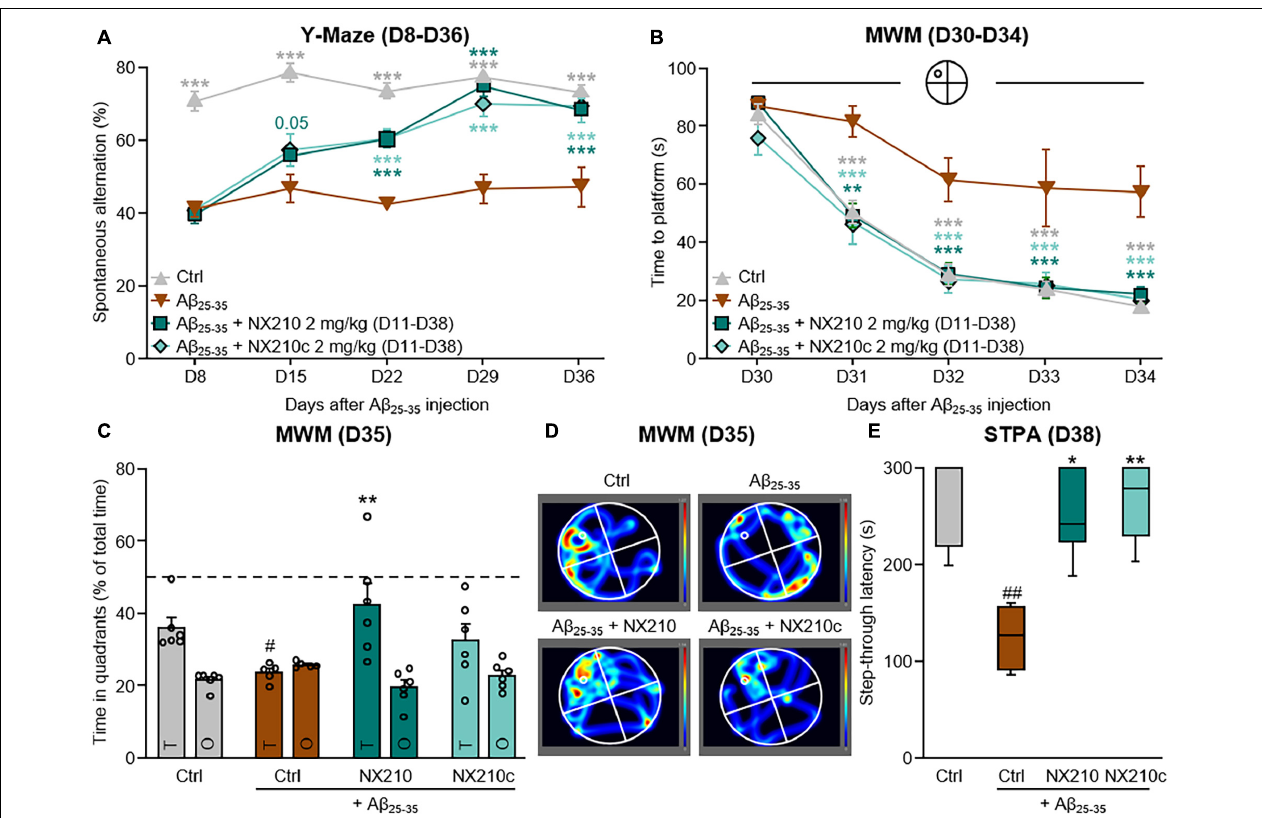
FIGURE 4 | Late-stage daily treatment with NX210 or NX210c restores amyloid-beta 25 - 35 (A β 25 - 35 )-induced short-term cognitive impairments in mice. Mice were injected intracerebroventricularly with scrambled control peptides (Ctrl) or A β 25 - 35 oligomers, and treated intraperitoneally once a day with vehicle, NX210 or NX210c (2 mg/kg) from day 11 (D11) until the end of the experiment (D38). They were subjected to several behavioral tests to evaluate learning and memory. (A) Spontaneous alternation in the Y-maze was assessed weekly from D8 to D36 to study spatial working memory. Late-stage daily treatment with NX210 and NX210c restored working memory deficit, as shown by the increased number of spontaneous alternations in the Y-maze compared with A β 25 - 35 -injected mice treated with vehicle. The data are presented as means and SEM. Two-way ANOVA followed by Tukey’s multiple comparisons test: *** p < 0.001 compared with A β 25 - 35 . (B–D) Morris water maze test was performed from D30 to D35 to assess spatial learning (B) and retention memory (C,D) . Late-stage daily treatment with NX210 and NX210c restored A β 25 - 35 -induced spatial learning and memory deficits, as shown by the decreased time to find the platform during the learning phase and the increased time spent in the target quadrant (T) versus other quadrants (O) during the retention phase in the Morris water maze compared with A β 25 - 35 -injected mice treated with vehicle. The data are presented as means and SEM. Two-way ANOVA followed by Tukey’s multiple comparisons test: (B) *** p < 0.001, ** p < 0.01 compared with A β 25 - 35 ; (C) # p < 0.05 compared with Ctrl; ** p < 0.01 compared with A β 25 - 35 . (E) Late-stage daily treatment with NX210 and NX210c restored contextual long-term memory deficit in a dose-dependent manner, as shown by the increased time to enter the dark compartment in the step-through passive avoidance test performed at D38 compared with A β 25 - 35 -injected mice treated with vehicle. The data are presented as medians and interquartile range. Kruskal–Wallis followed by Dunn’s test: ## p < 0.01 compared with Ctrl; ** p < 0.01, * p < 0.05 compared with A β 25 - 35 . (A–D) n = 6 Ctrl, A β 25 - 35 + NX210, A β 25 - 35 + NX210c, n = 5 A β 25 - 35 .